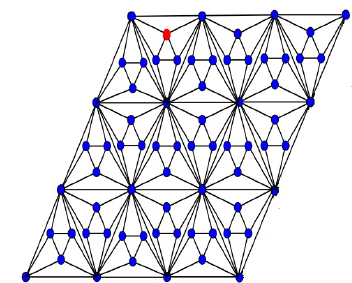
Figure 4. Rectangular hex-derived network of type 3 ( RHDN 3 ( 4,4 ) ).